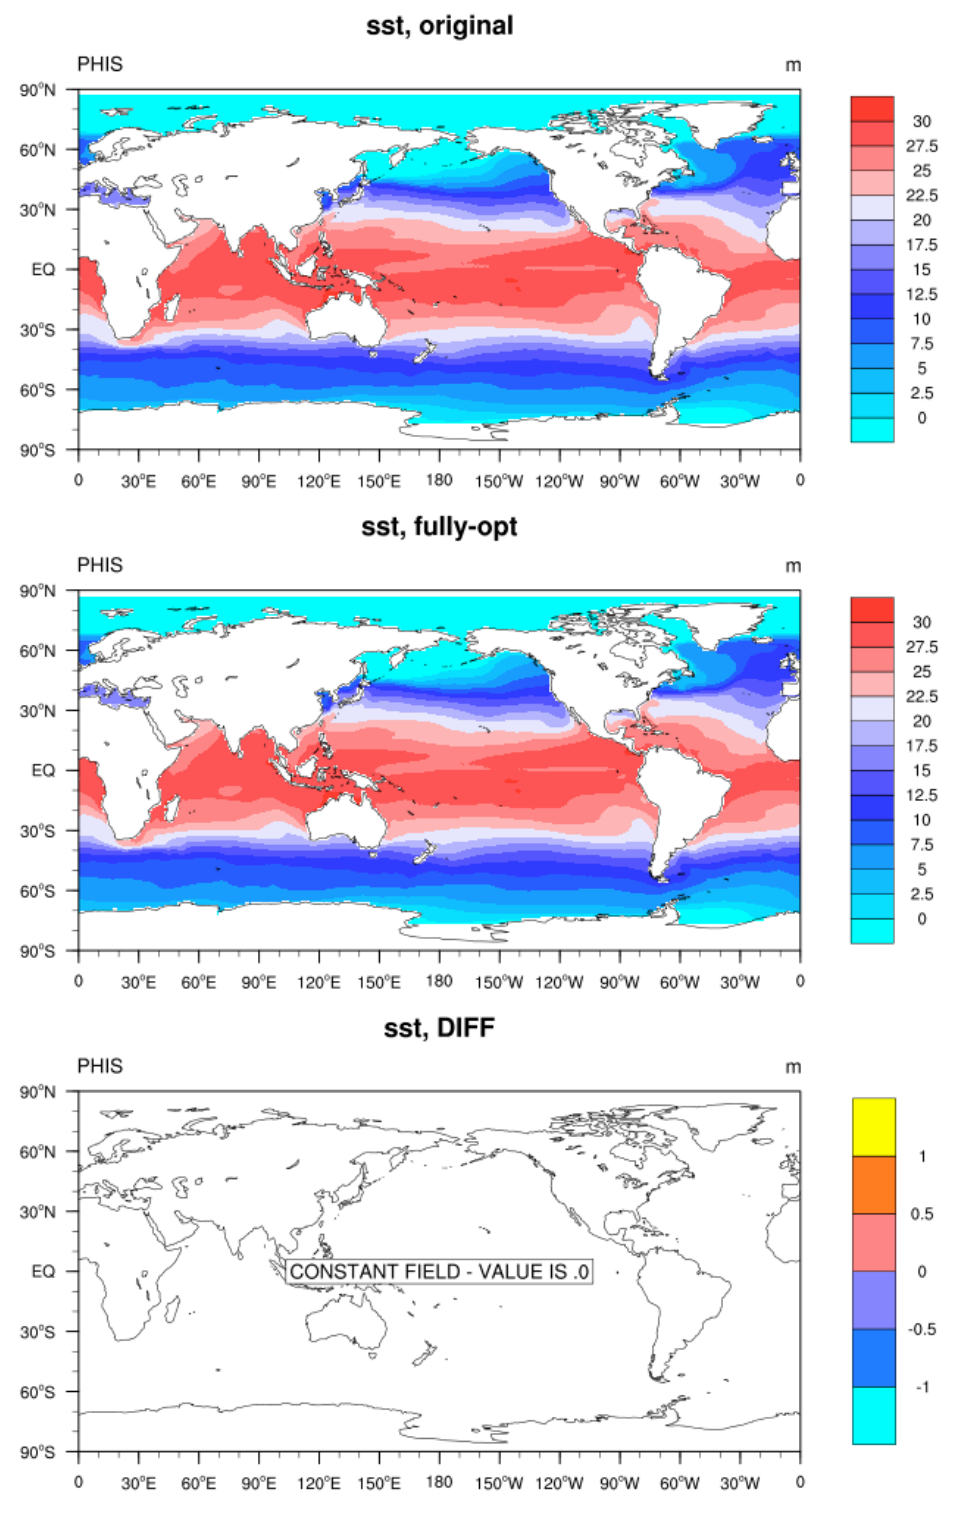
Figure 13. Correctness of